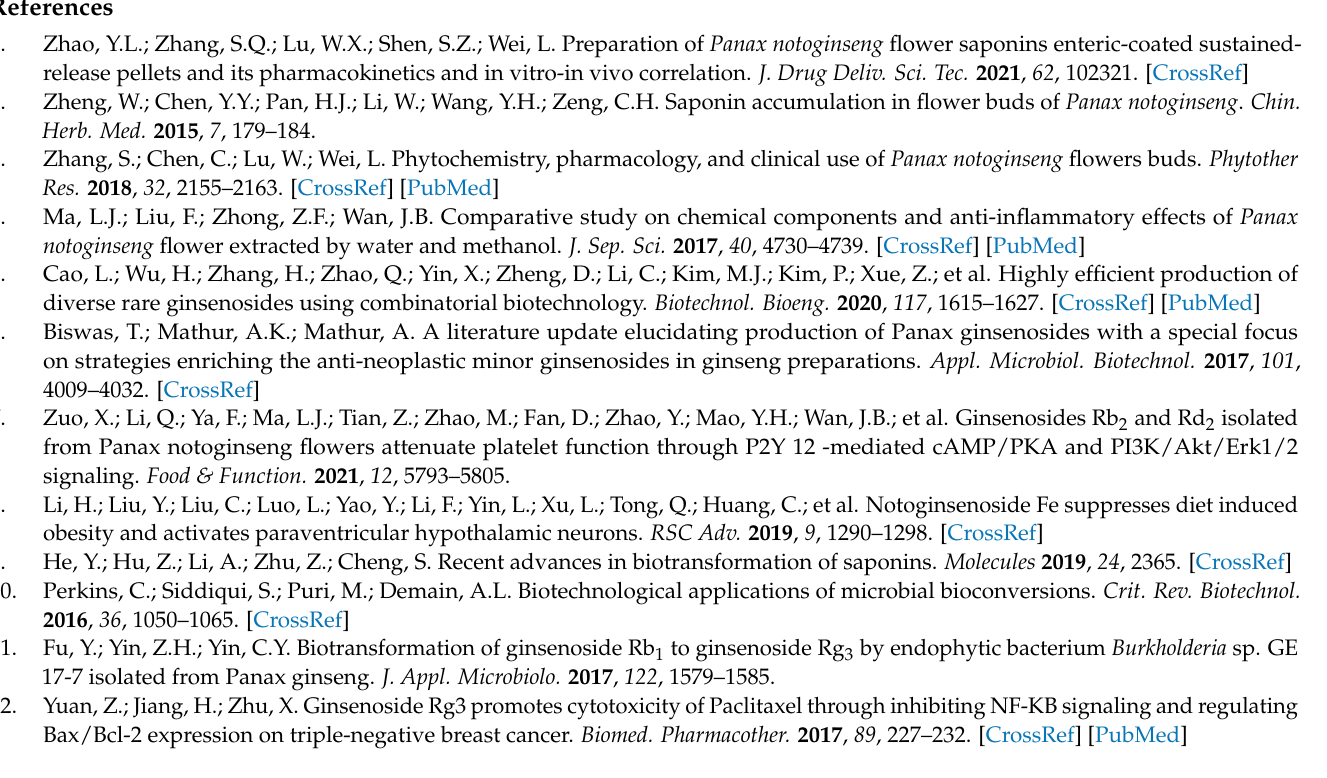
Fc by crude enzymes, Figure S7: 1 H NMR, 13 C NMR (C 5 D 5 N), and MS spectra of compound 1 , Figure S8: 1 H NMR, 13 C NMR (C 5 D 5 N), and MS spectra of compound 2 , Figure S9: 1 H NMR, 13 C NMR (C 5 D 5 N), and MS spectra of compound 3 , Figure S10: HPLC analysis of the transformation products of mixture of same mass of ginsenoside by C. xylophilum